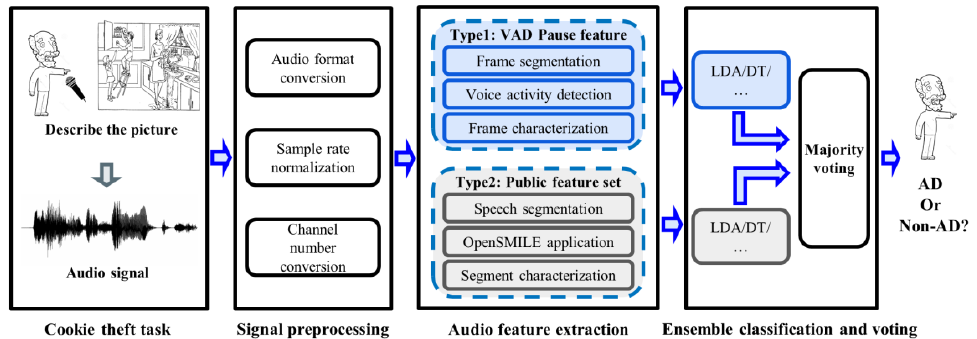
Figure 1. System framework for AD detection. LDA, linear discriminant analysis; DT, decision trees ; AD, Alzheimer’s